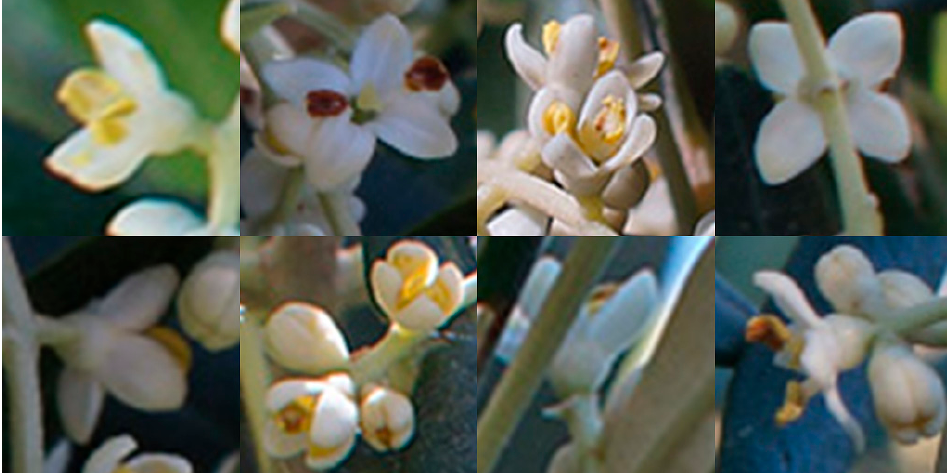
Figure 3. Examples of open flowers (magnified details).